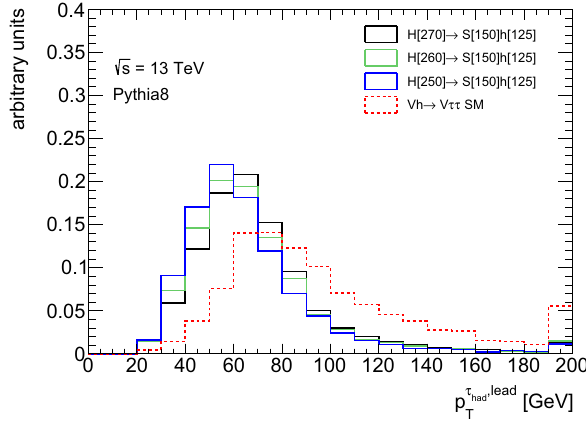
Fig. 4 Transverse momentum of the leading hadronic tau for several H → Sh samples (solid lines) compared with the SM Vh process with h → ττ (dashed line) generated with PYTHIA8 . The last bin contains overflow